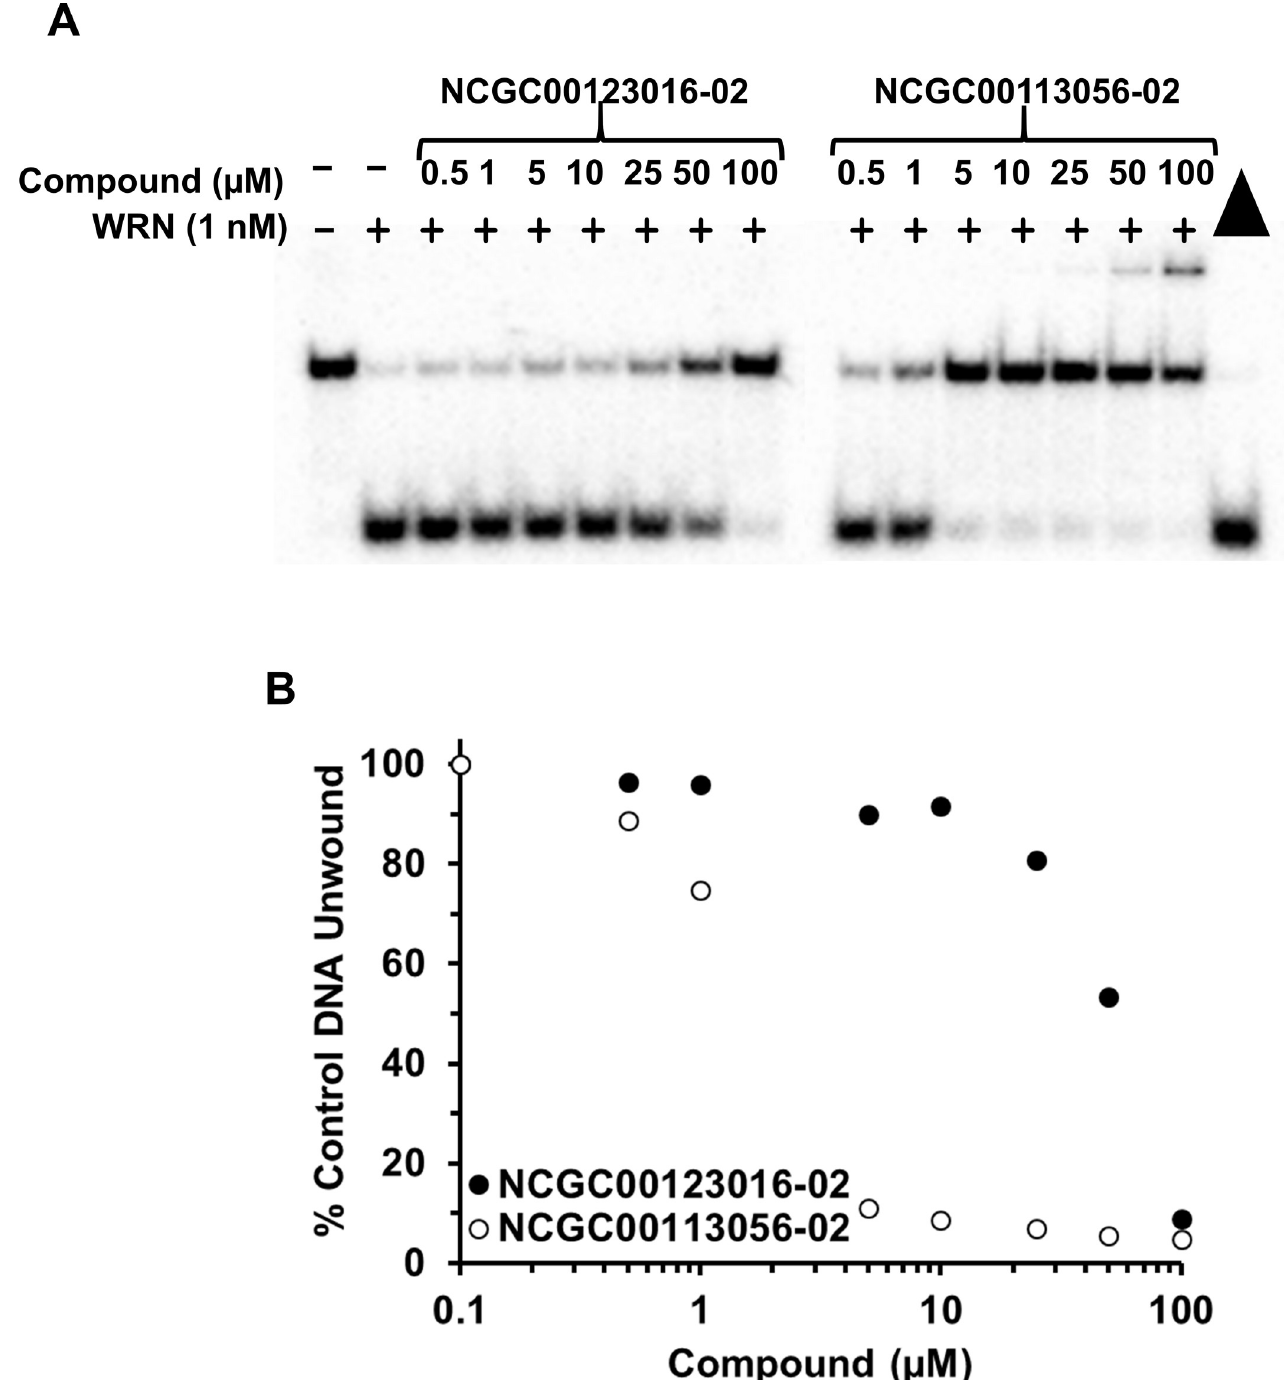
Fig 6. Radiometric helicase assay to determine IC 50 values for compound inhibition of full-length WRN helicase activity. (A) Gel image of full-length WRN (1 nM) unwinding of the radiolabeled FORKR DNA substrate (0.5 nM) in the presence of increasing amounts of NCGC00123016-02 and NCGC00113056-02 (0–100 μ M). (B) Quantitation of Fig 6A. Unwinding by WRN in the presence of vehicle (DMSO) is set to 100% control DNA unwinding. The x-axis is displayed in log scale.